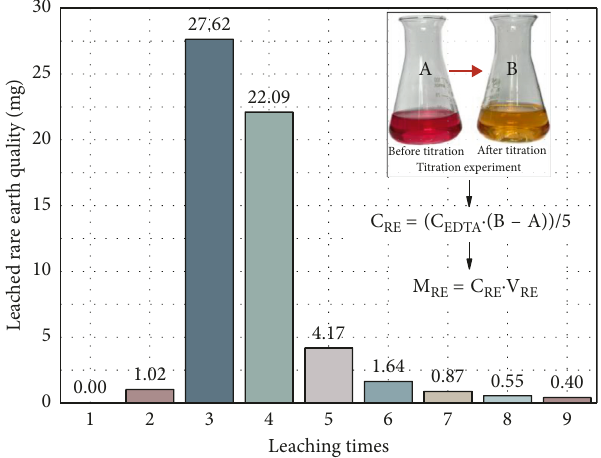
Figure 4: Recovery of the rare earth mass ion distribution.